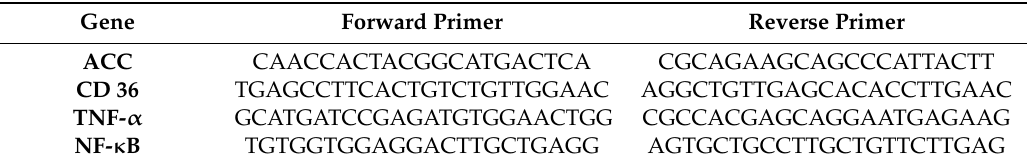
Table A1. The sequences of the primers used in real-time PCR.